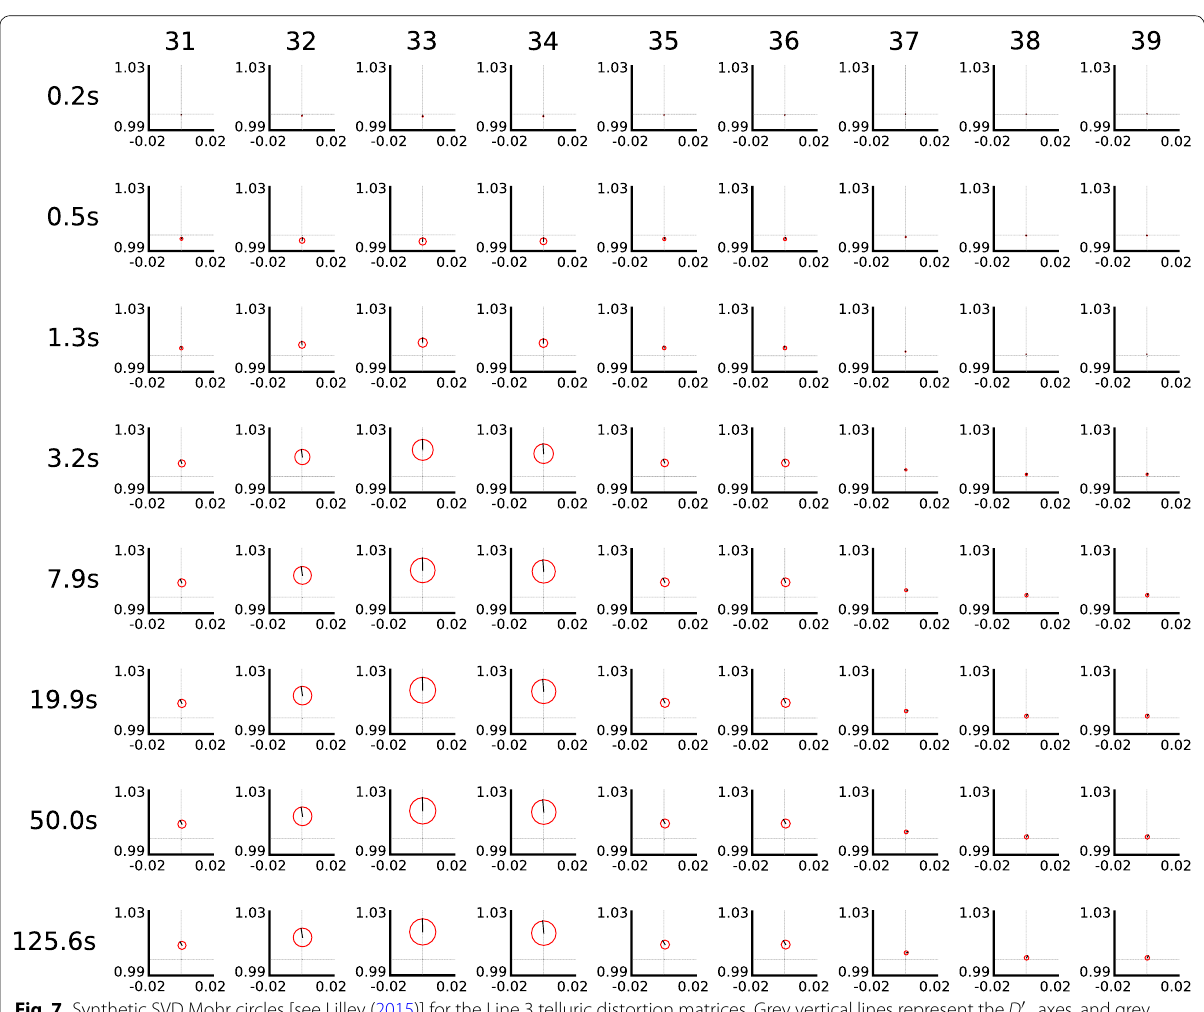
Fig. 7 Synthetic SVD Mohr circles [see Lilley (2015)] for the Line 3 telluric distortion matrices. Grey vertical lines represent the D ′ xx axes, and grey horizontal dashed lines represent D ′ xy axes. The interaction of the black radius with the red circle marks the observed